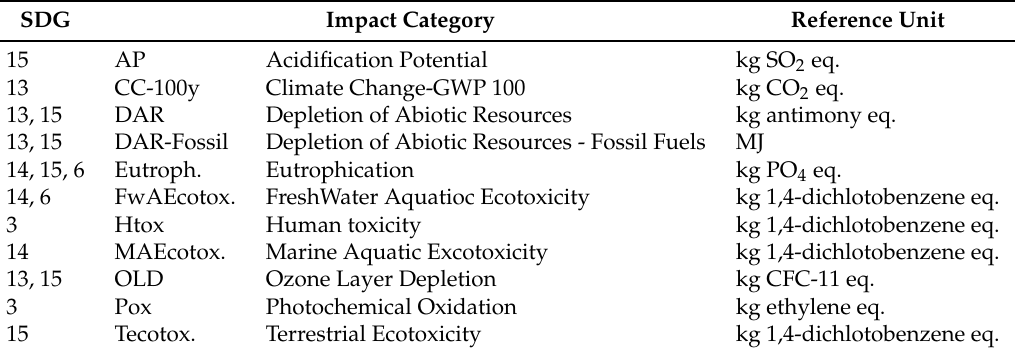
Table 6. CML impact categories and correlated Sustainable Development Goals